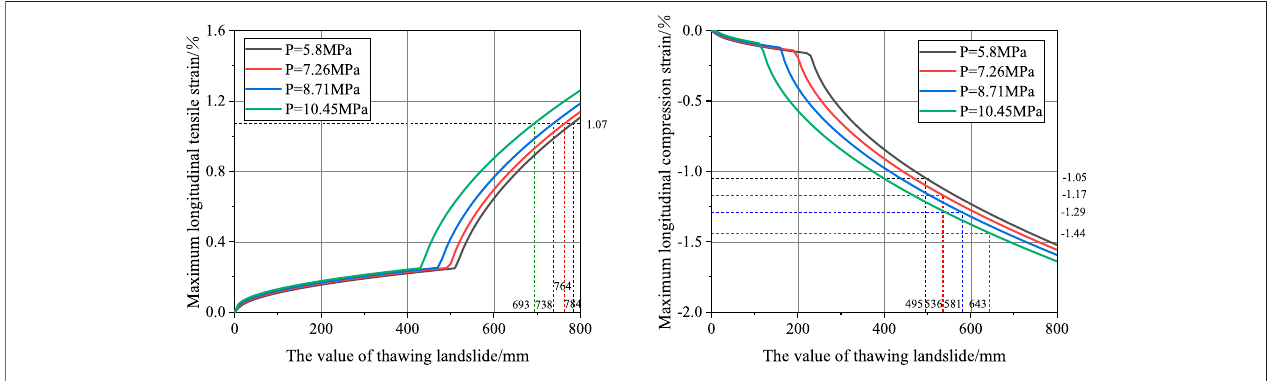
FIGURE 14 | The effect of operating internal pressure on the maximum longitudinal strain.